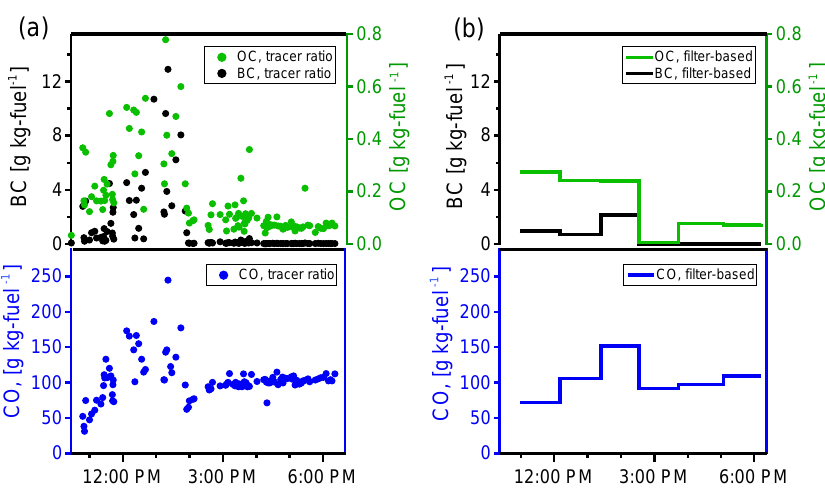
Figure 2. Temporal profiles of fuel-based CO, BC, and OC emission factors (g ( kg fuel ) − 1 ) for the traditional-fixed kiln obtained with the AML and the tracer ratio technique (a) and with the sampling probe technique (b)